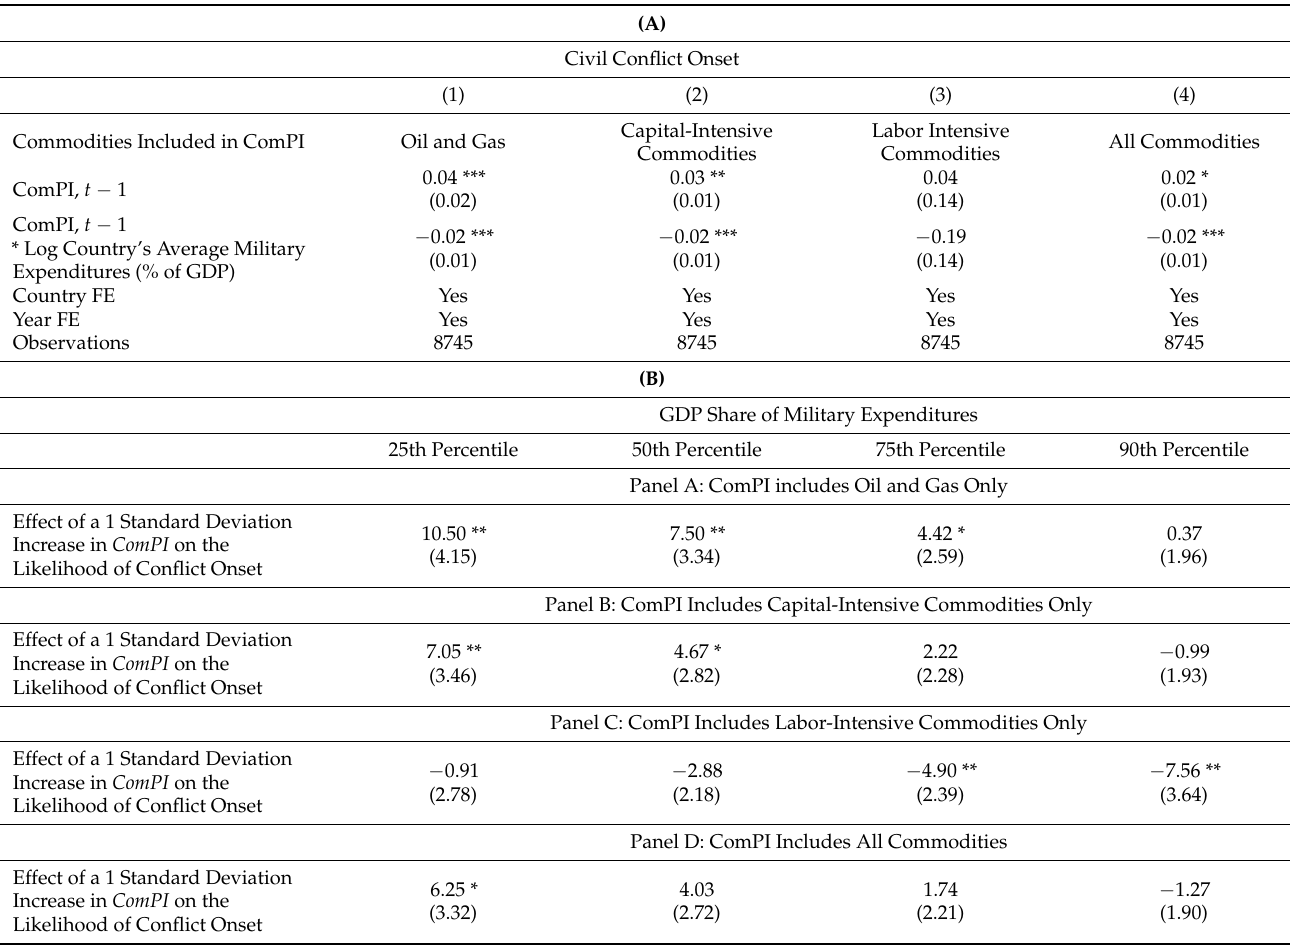
Table 11. ( A ) Commodity Price Shocks and Civil Conflict: The Role of Military Expenditures. ( B ) Effects of a Commodity Price Windfall on the Likelihood of Civil Conflict Onset at Different Percentiles of Military Expenditures. (A)